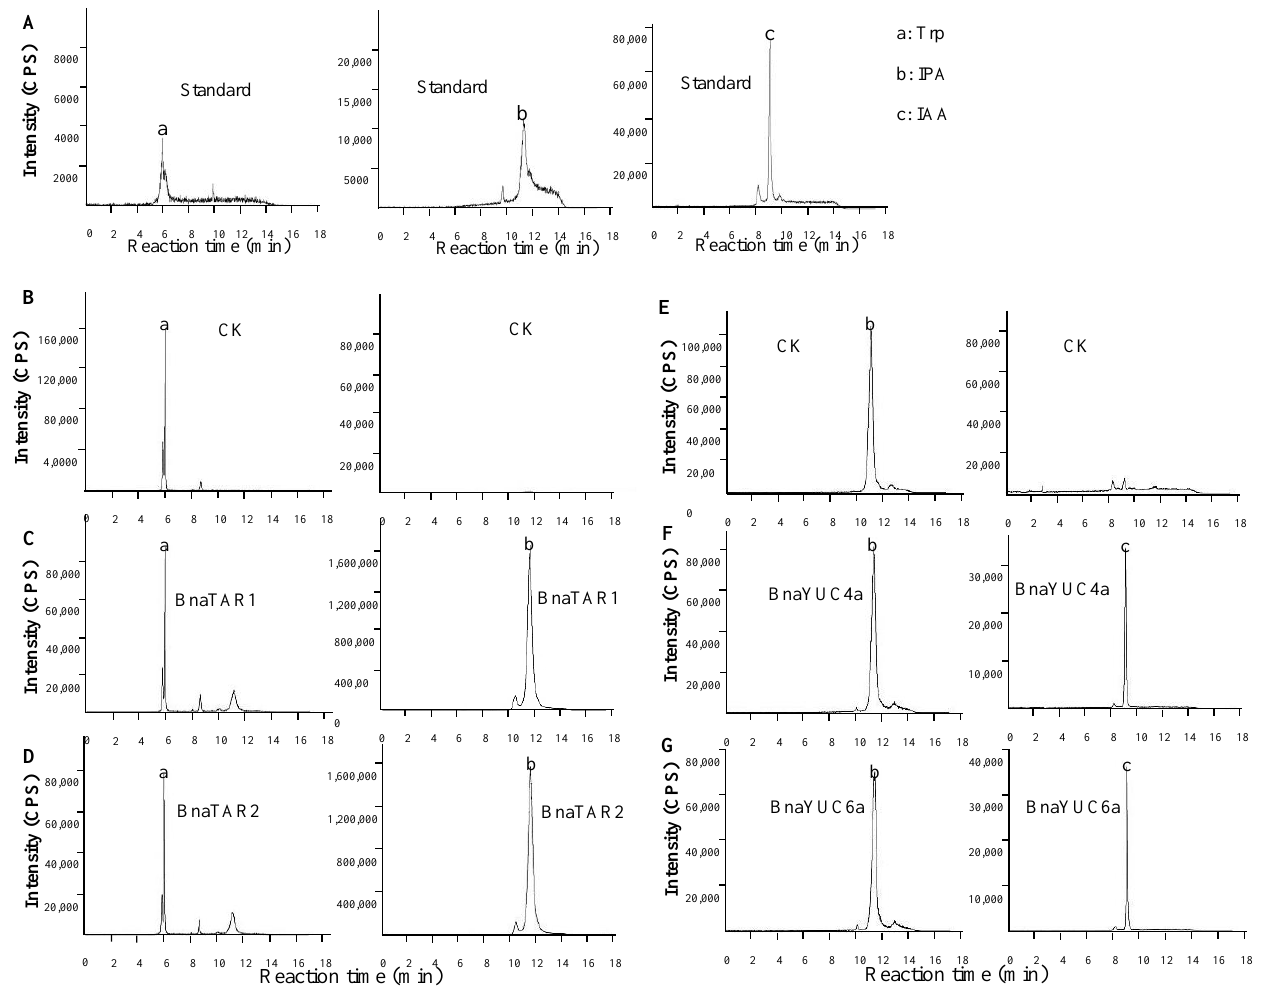
Figure 4. Enzymatic analysis of BnaYUCs and BnaTAR proteins: ( A ) Chromatogram of Trp, IPA and IAA authentic standard. ( B ) Enzyme reaction mixture for Trp with protein tag. ( C , D ) Enzyme reaction mixture for Trp with purified BnaTAR1 and BnaTAR2 protein, respectively. ( E ) Enzyme reaction mixture for IPA with protein tag. ( F , G ) Enzyme reaction mixture for IPA with purified BnaYUC4a and BnaYUC6a protein, respectively. Arrows indicate the Trp (a), IPA (b) and IAA (c) peaks.